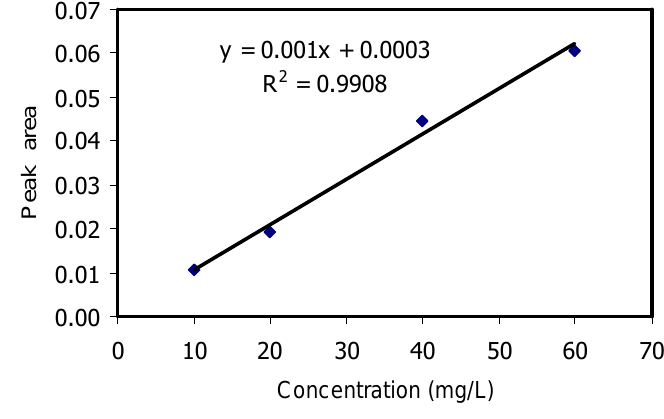
y = 0.001x + 0.0003 R 2 =